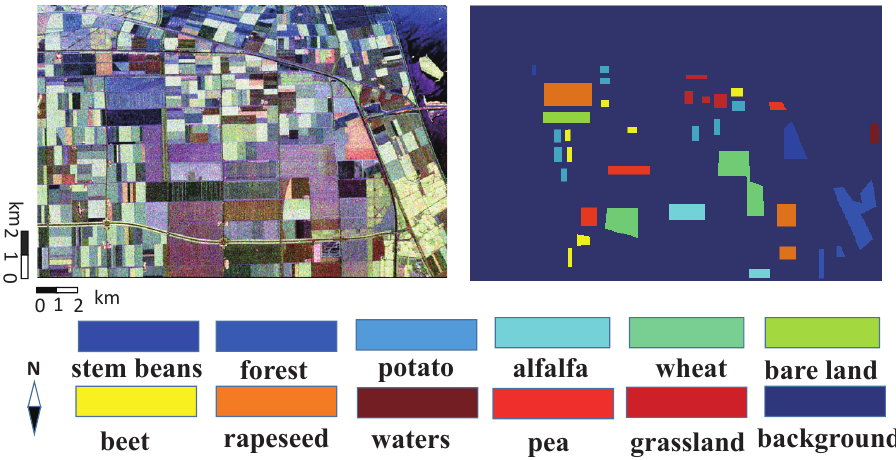
Figure 3. Flevoland I dataset: Pauli image (left) and ground truth image (right).